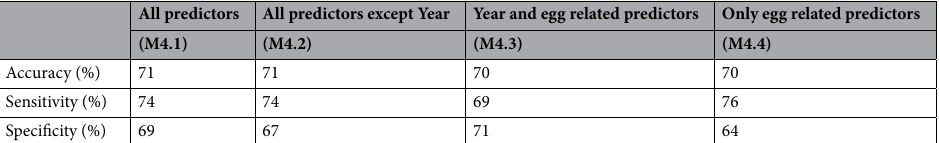
Table 2. Averaged outputs of 2 age classes random forest analyses for 4 different versions of predictor combinations. Accuracy, sensitivity and specificity are model evaluation values. Parameters included in each model are: (1) Model M4.1, mean egg volume per nest (VM), total egg volume per nest (VT), clutch size (Clutch), year, fish landings (Food), fish landings available per capita (Foodpc), population size of Audouin’s gulls breeding pairs (LaPopsize), total population size of breeding pairs (Audouin’s gulls plus Yellow-legged gulls) (Popsize), winter North Atlantic Oscillation index (WNAO) and annual North Atlantic Oscillation index (ANAO), (2) Model M4.2, same as M4.1 without year factor, (3) Model M4.3, mean egg volume per nest, total egg volume per nest, clutch size and year and (4) Model M4.4, same as M4.3 without year